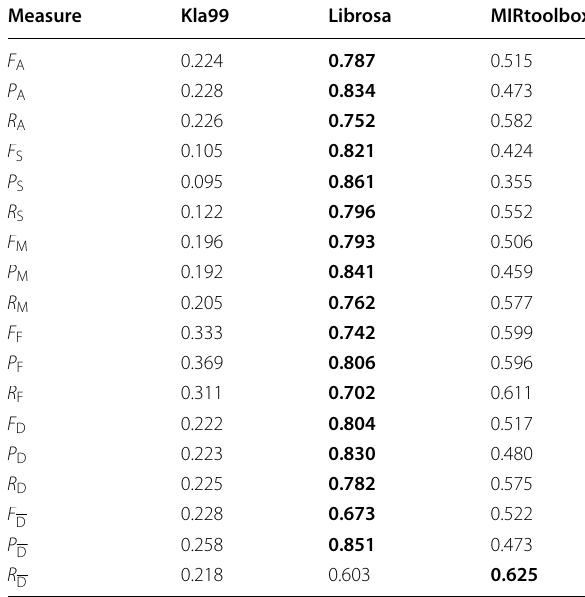
Table 6 Balanced classification errors for recognition of instrument groups. CNN-AlexNet: adaptation after [63]; CNN-Han: adaptation after [64, 65]; CNN-VGG16: adaptation after [66]. Best values are marked with bold font a Instr.